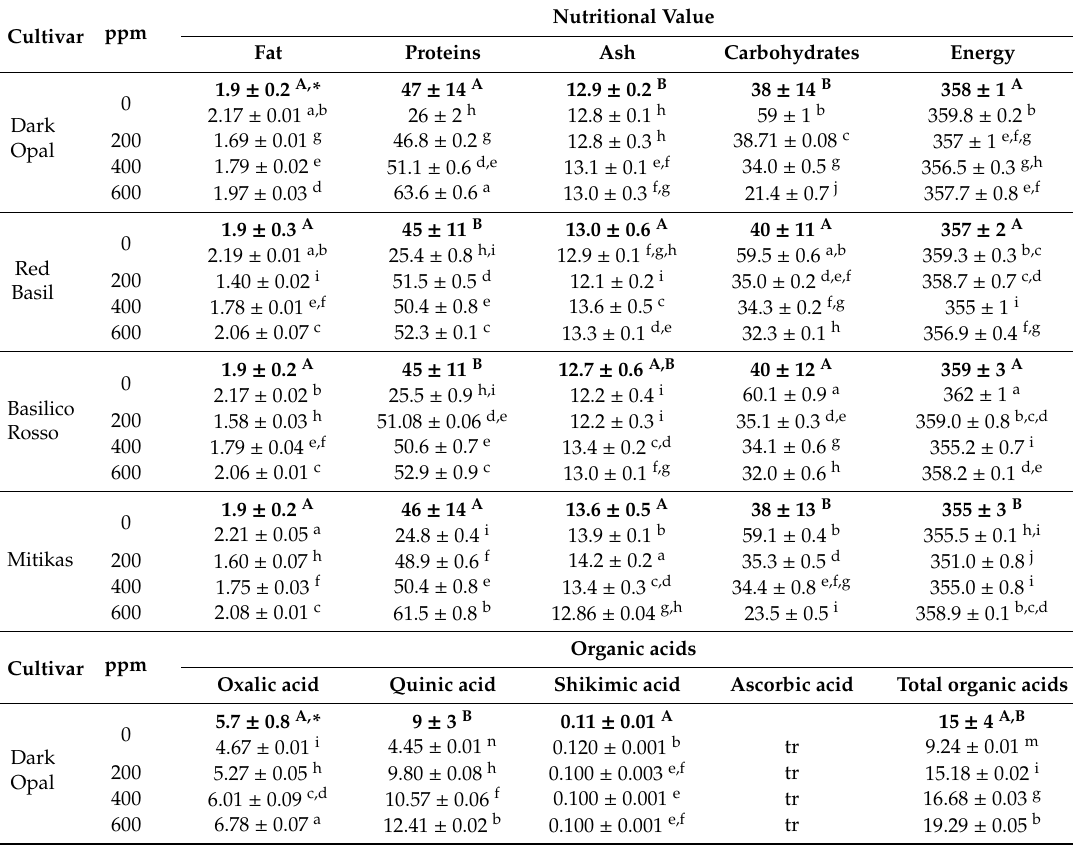
Table 1. Nutritional value (g / 100 g dw), energetic value (kcal / 100 g dw) and organic acids (g / 100 g dw) of the studied basil genotypes in relation to nitrogen input (mean ± SD, n =